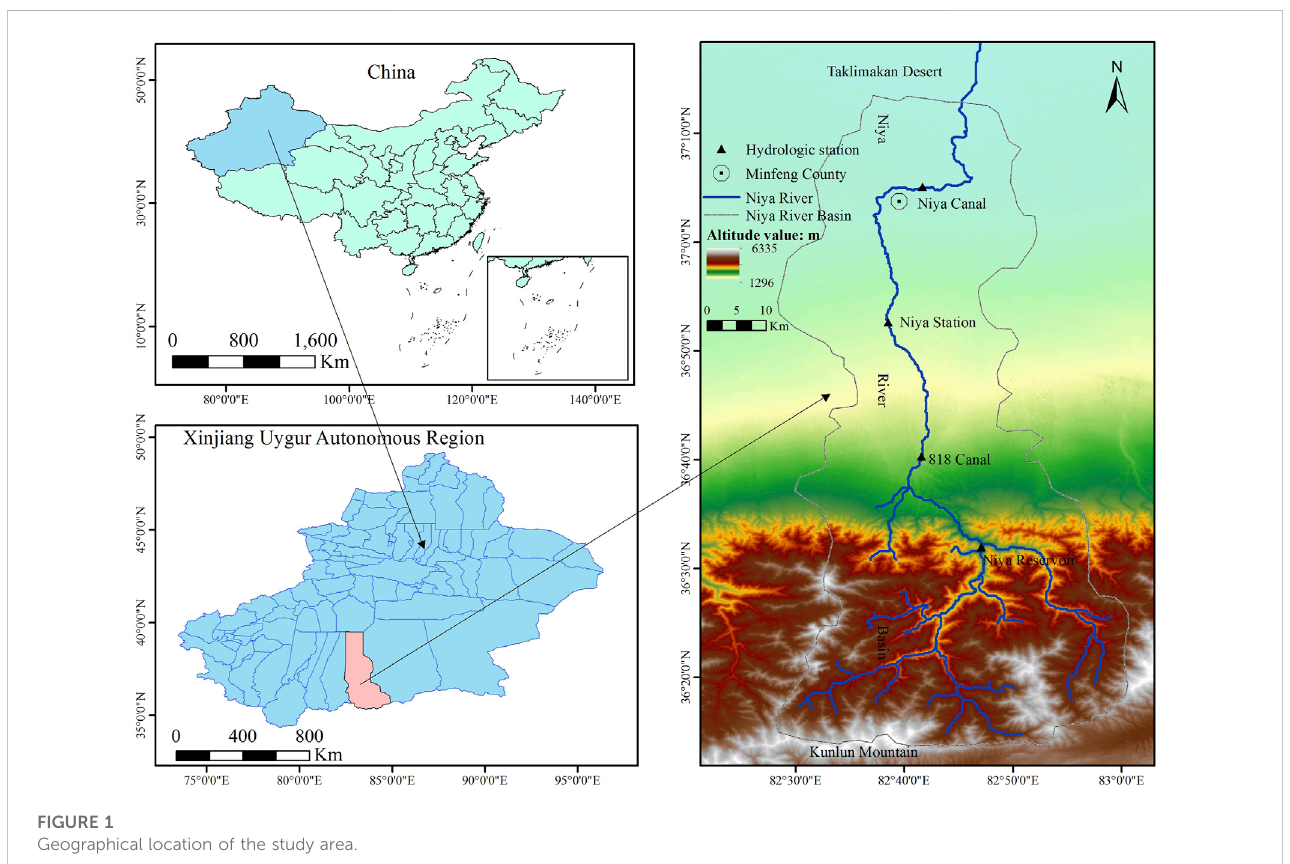
FIGURE 1 Geographical location of the study